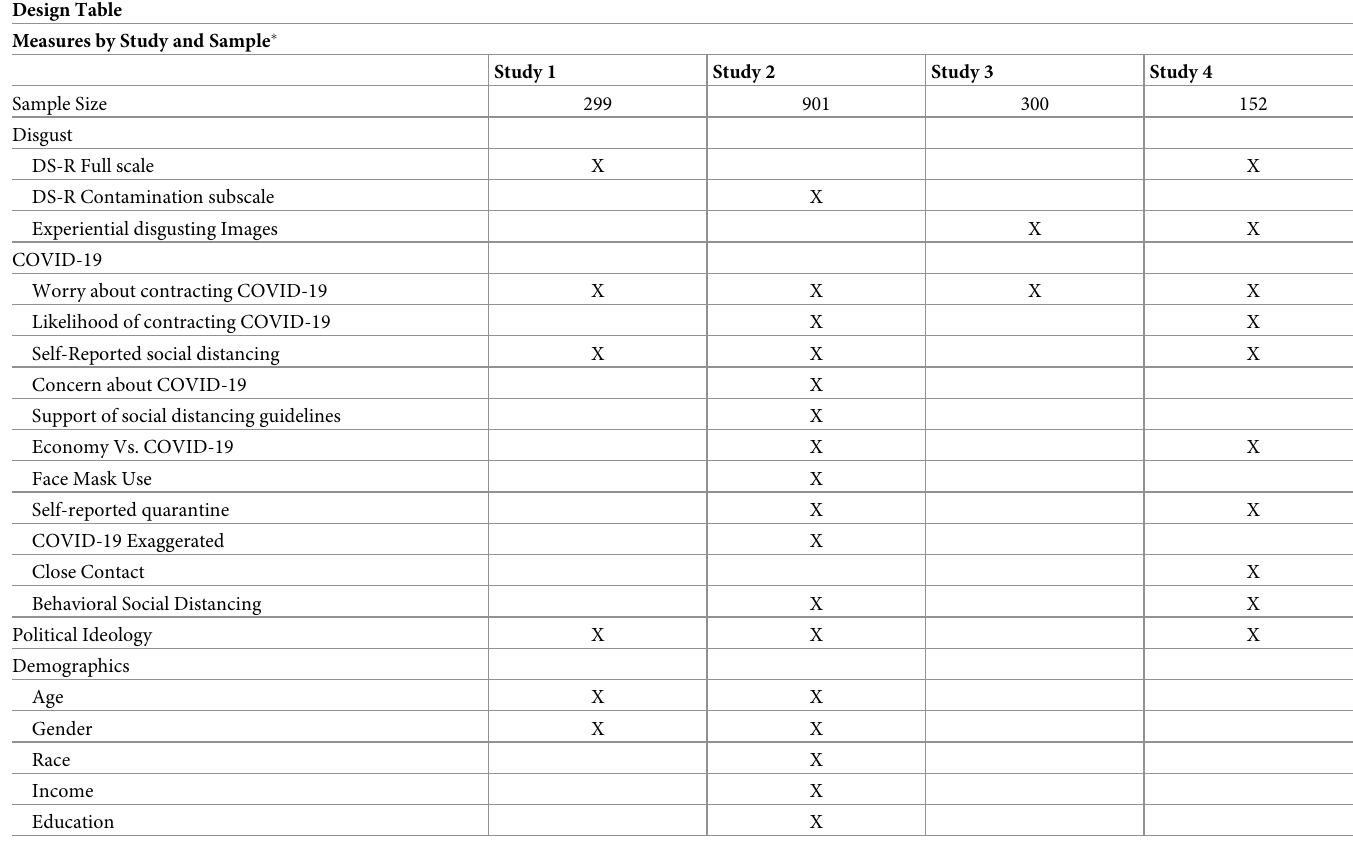
Table 1. Design for all studies. Design